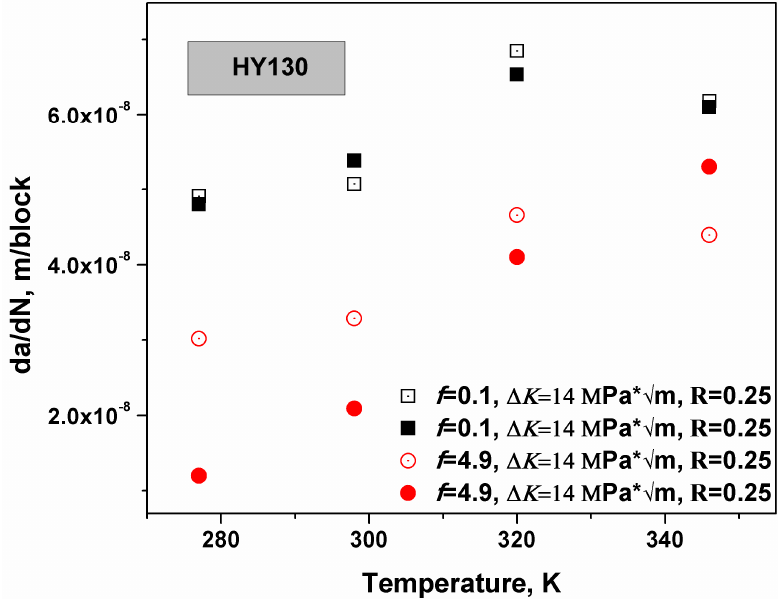
Figure 5. This schematic illustrates the temperature dependence of crack growth in HY130 steel [33]. As f < f critical , the crack growth rate was maximized at 320 K. 211